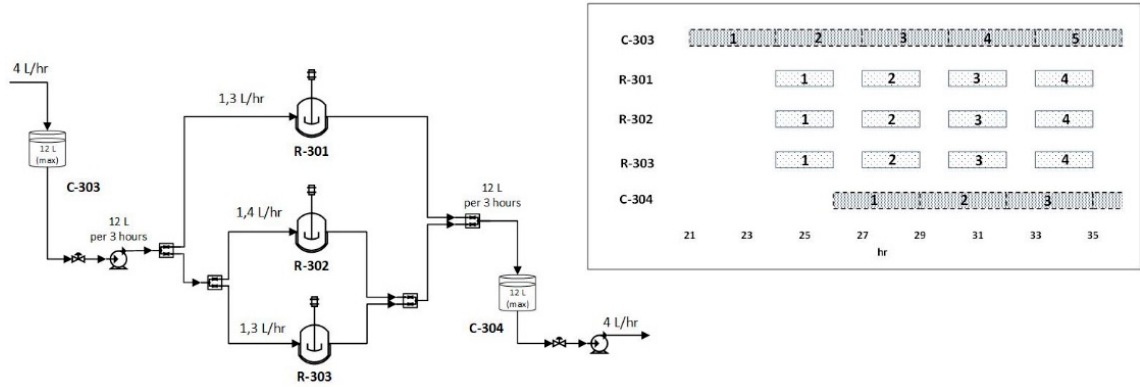
Figure 7. Flow rate and correlated operational time schedule for the IVT reactors R-301, R-302, R-303 and their auxiliary, accumulation vessels C-301, C-302.